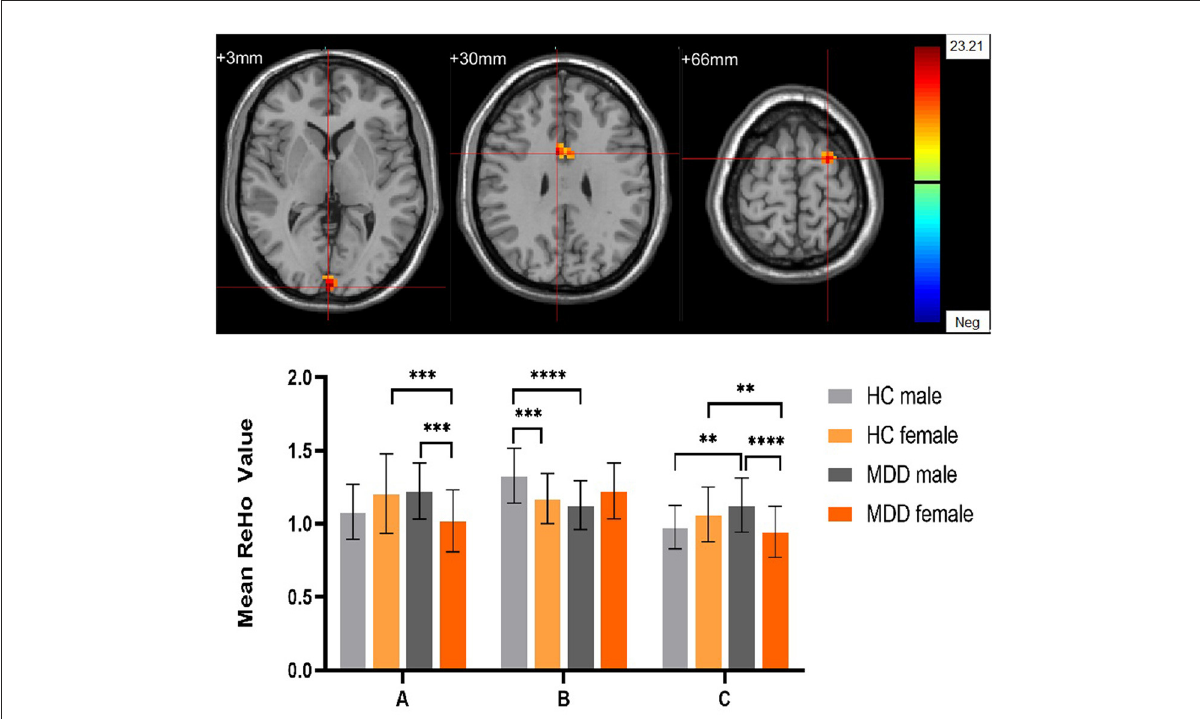
FIGURE6 The diagnosis group × gender group interaction. Regions with diagnosis group × sex group interactions include (A) The left Calcarine; (B) The right median cingulate gyrus; (C) The left dorsolateral superior frontal gyrus (cluster-level threshold of p < 0.05 after GRF correction). The color bar represents the range of F values. R = right, L = left. The graph shows the ReHo values (mean ± standard deviation) extracted from regions with the diagnosis groups × sex group interaction. The Y-axis represents ReHo values. The X-axis represents regions with the diagnosis groups × gender group interaction. **** p < 0.001; *** p < 0.005; ** p <